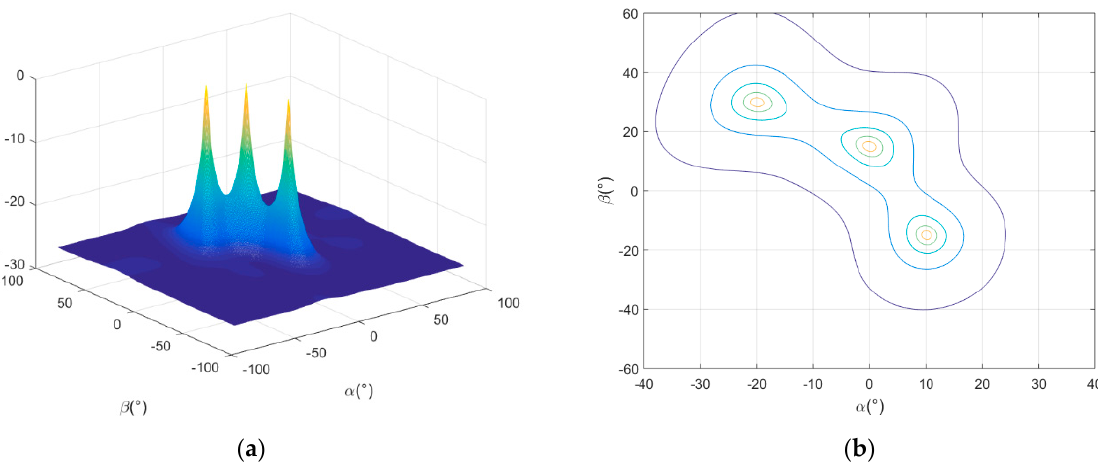
Figure 7. 2D MUSIC estimation results with self-calibration. ( a ) Spatial spectrum; ( b ) Contour map.